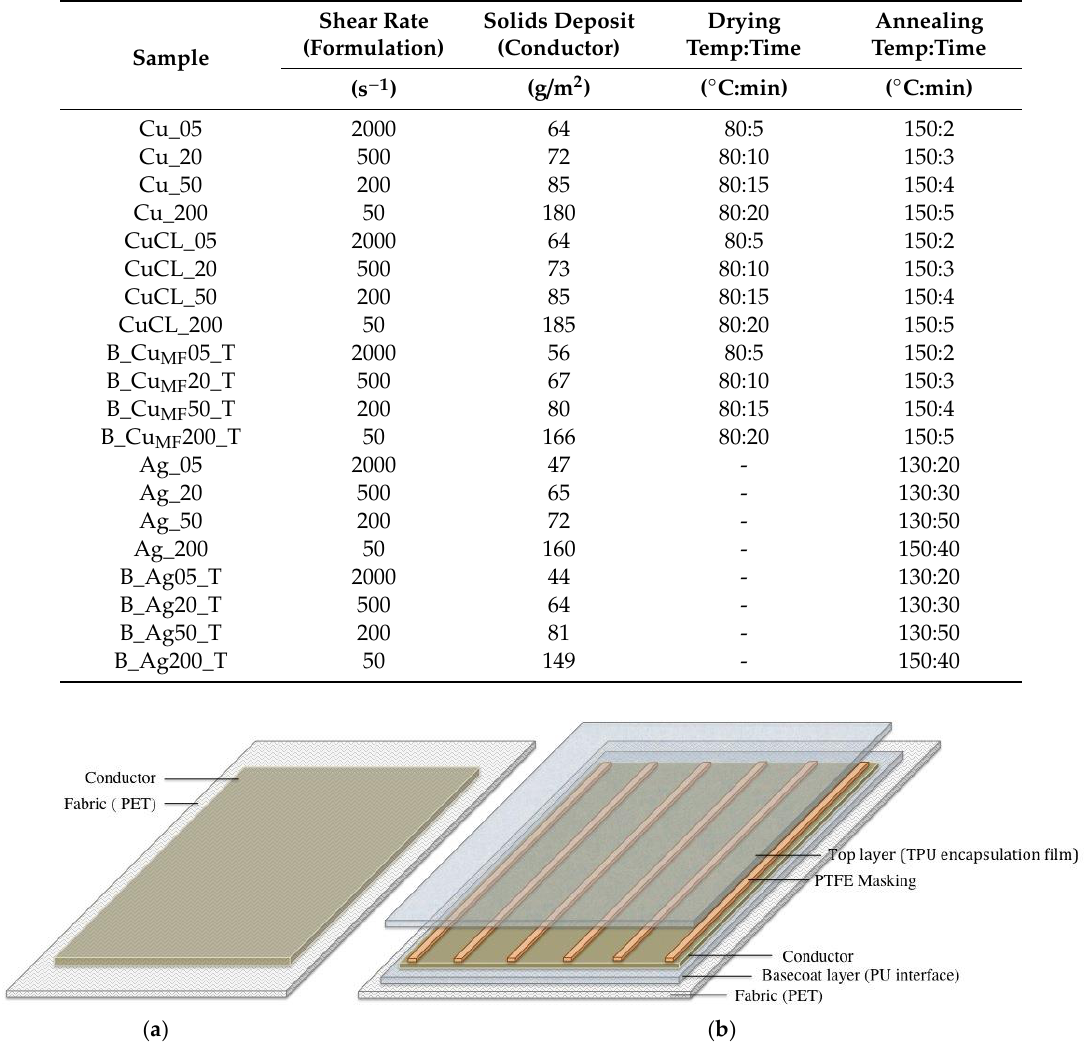
Figure 1. Illustration of the coated samples with different constructions: ( a ) conductor on plain fabric and ( b ) layered construction of an encapsulated conductor with PTFE masking prepared for washing treatments.